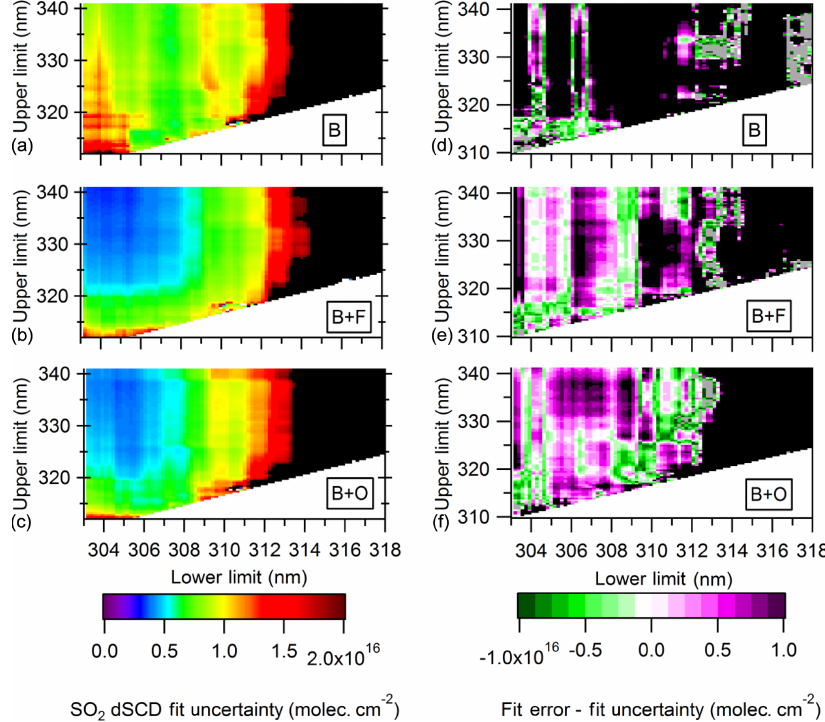
Figure 10. Lower concentration SO 2 dSCDs’ fit errors (a, b, c) and the difference between the fit uncertainty and error (d, e, f) from spectra measured at a 2 ◦ elevation angle for the base case, B; with the offset, B + O; and with the filter, B + F. Black areas indicate errors of >2 . 2 × 10 16 molec.cm − 2 for the absolute error (a, b, c) and a >1 . 1 × 10 16 molec.cm − 2 underestimation of the fit error by the fit